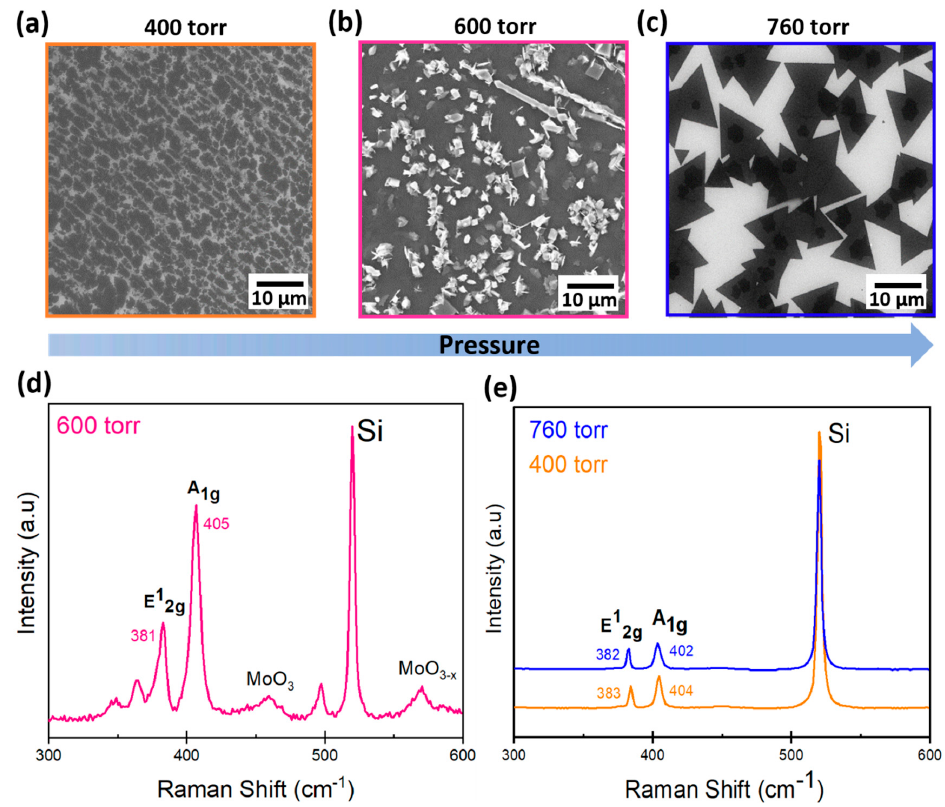
Figure 2. Scanning electron microscopy (SEM) images (planar view) of MoS 2 grown on SiO 2 at different pressures: ( a ) 400 torr, ( b ) 600 torr, and ( c ) 760 torr; ( d ) Raman spectrum of MoS 2 at a pressure of 600 torr, and ( e ) Raman spectra of MoS 2 on monolayer domains at 760 torr (blue) and on MoS 2 particles at 400 torr